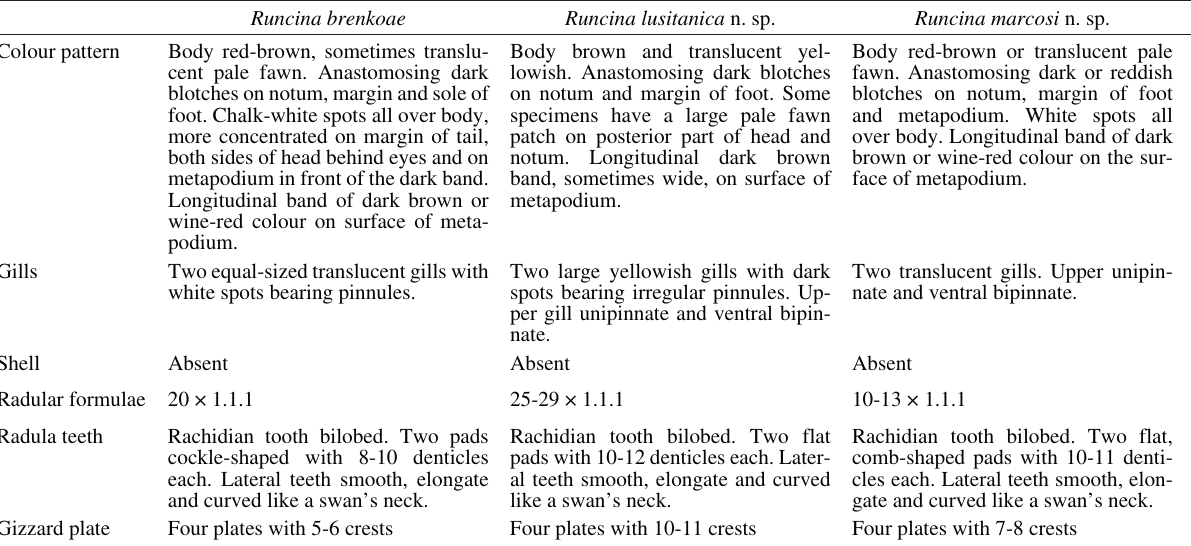
Table 3. – Differences between Runcina brenkoae , Runcina lusitanica n. sp. and Runcina marcosi n. sp. Data after Thompson (1980), Thomp- son and Brodie (1988), Schmekel and Cappellato (2002) and present study. Runcina brenkoae Runcina lusitanica n.